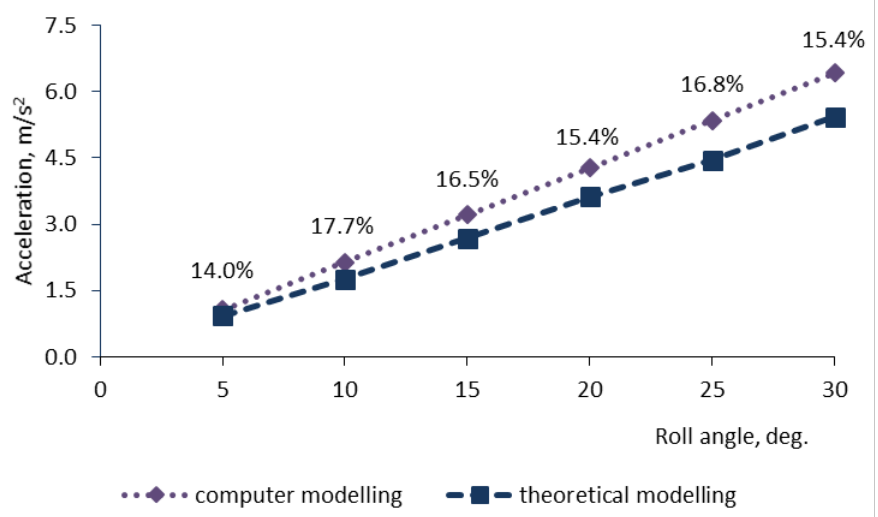
Figure 8. Dependence of container accelerations on the roll angle of a railway ferry and differences in the results of the theoretical and computer solution in percent.